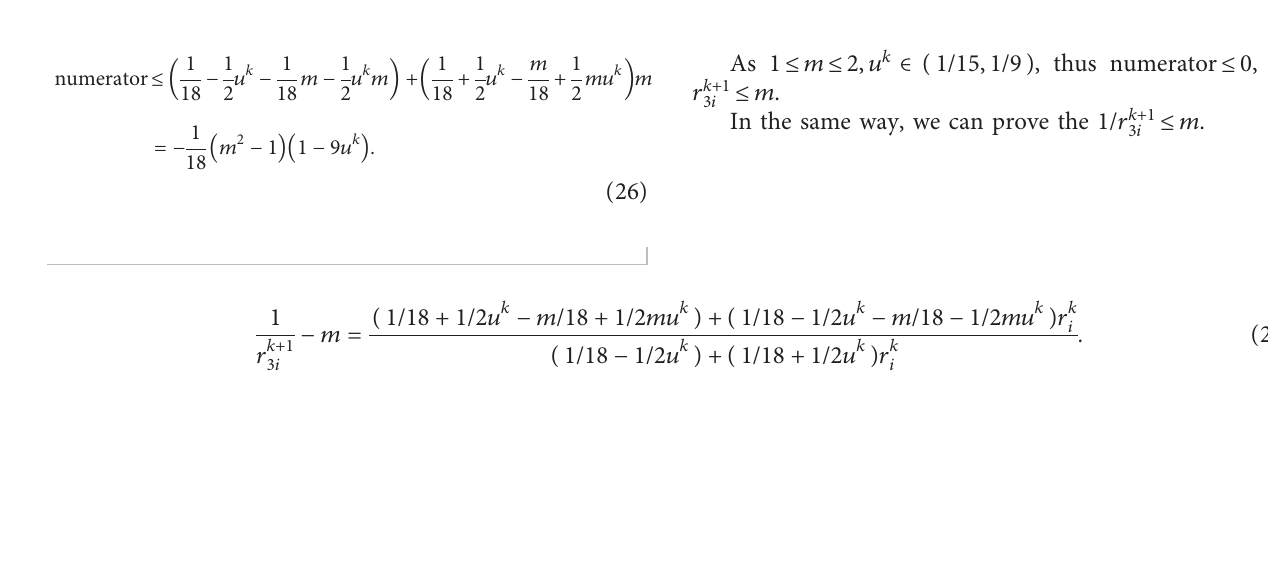
Figure 1: Limit curves and their curvature figures. (a) Stationary subdivision. (b) Curvature by (1). (c) Nonstationary subdivision. (d) Curvature by